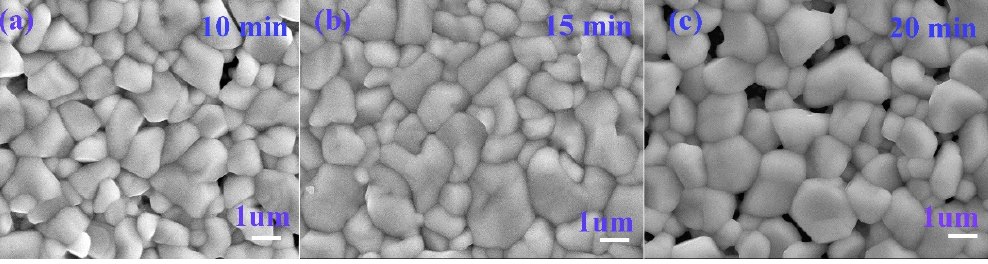
Figure 7. Surface morphology of the CNZTSSe thin films selenized at 10 min ( a ), 15 min ( b ), and 20 min ( c ).